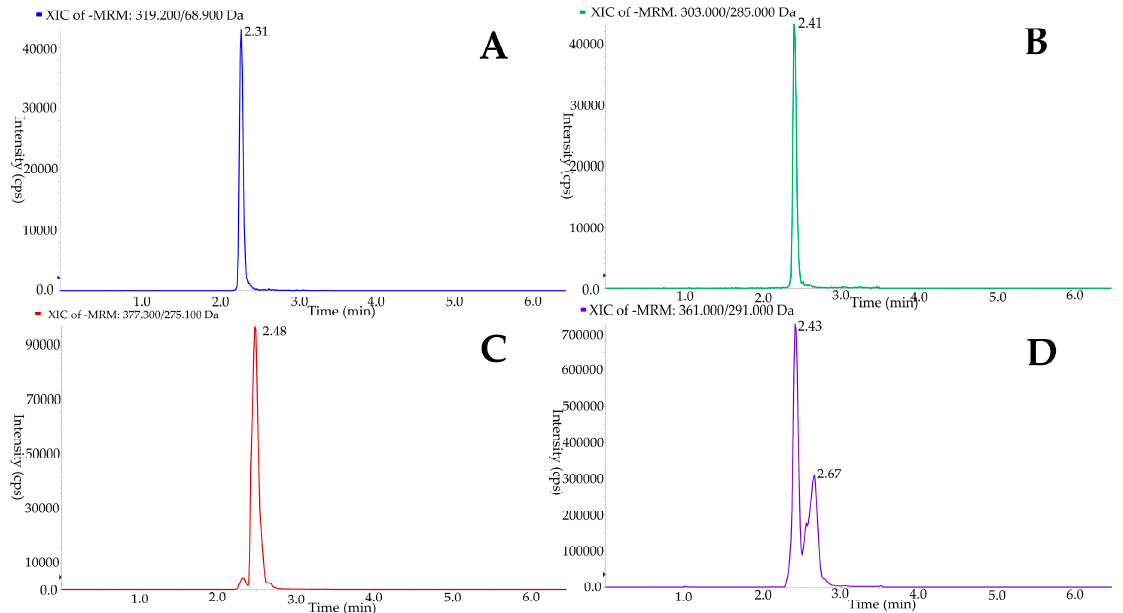
Figure 2. Example chromatogram of oleacein ( A ), oleocanthal ( B ), oleuropein aglycone ( C ), and ligstroside aglycone ( D ), the latter from a commercial “Picual”